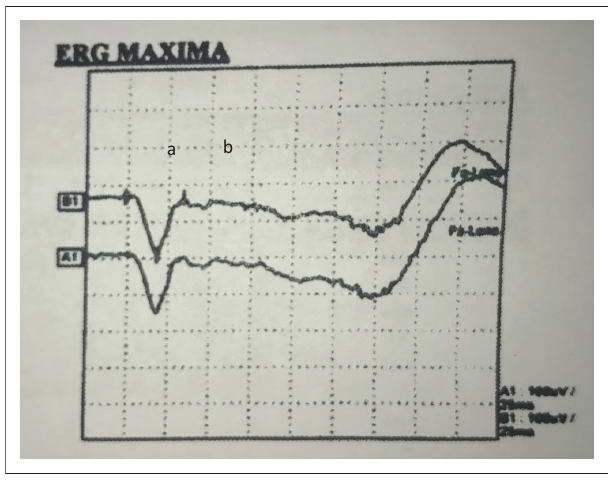
FIGURE 3: Electroretinogram (ERG) showing a selective reduction in b-wave